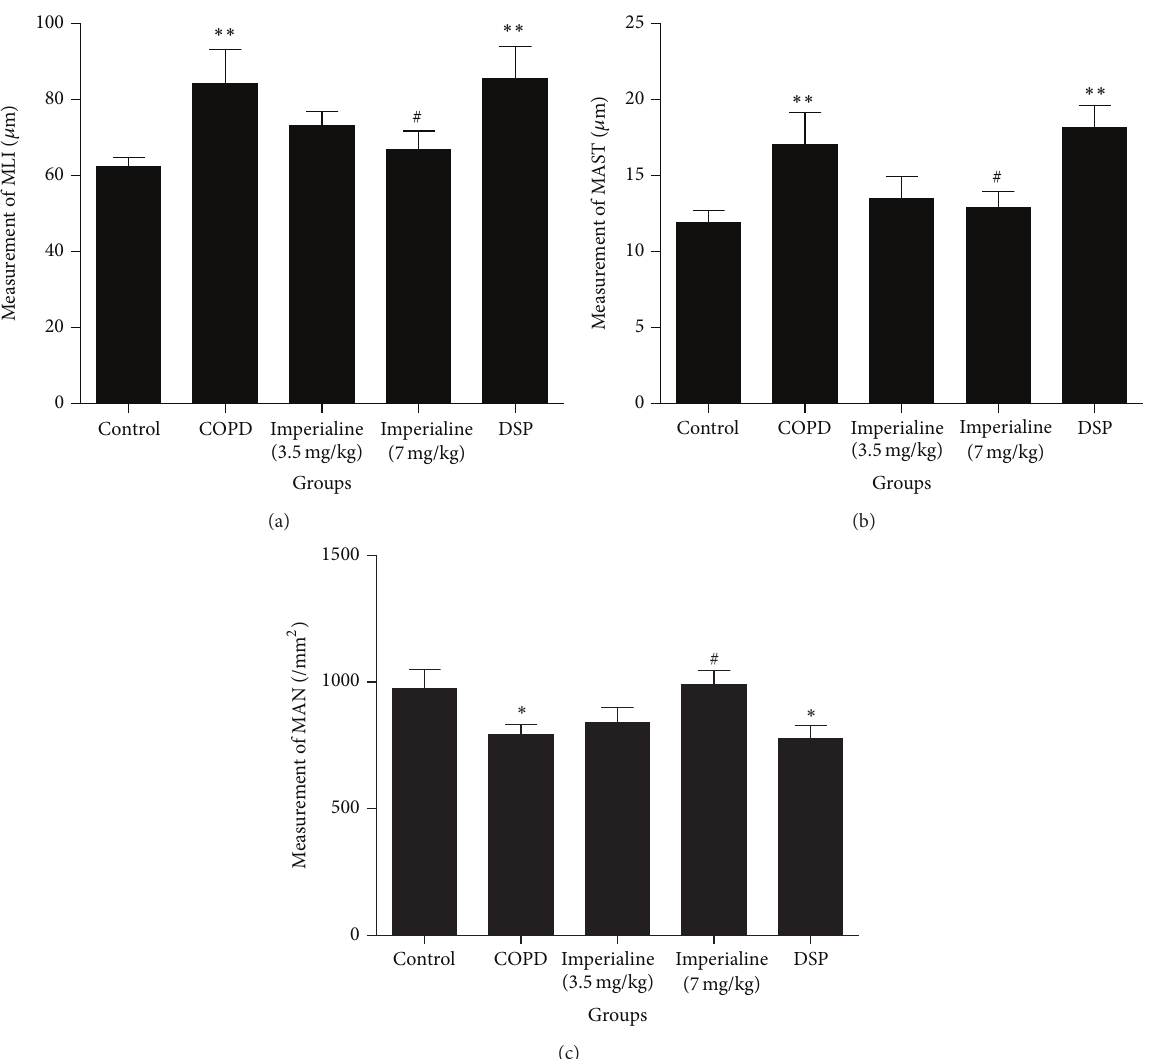
Figure 8: The effect of imperialine on (a) mean linear intercept (MLI), (b) mean alveolar septal thickness (MAST), and (c) mean alveolar number (MAN) of lung tissues of rats in different groups. Results were expressed as the mean ± SEM ( 𝑛 = 10 ). Significant differences compared with the control group were designated as ∗ 𝑃 < 0.05 and ∗∗ 𝑃 < 0.01 . Significant differences compared with the COPD group were designated as # 𝑃 < 0.05